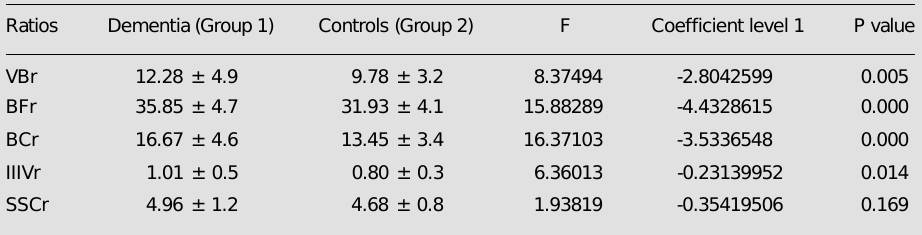
Table 1 - Brain ratios obtained for dementia patients and normal controls (MANOVA F-values, coefficients of the two-level factor comparison, and P value).